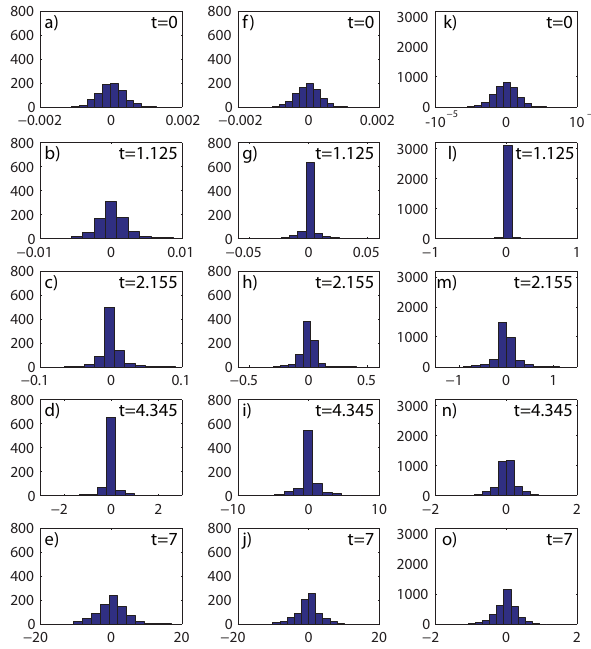
Fig. 4. Histograms of 20perturbations of an initial condition for (a) – (e) the simplified L96 model, (f) – (j) the slow variables x i of the L96 model with strong coupling ( h =1), and (k) – (o) the fast variable y j,i of the L96 model. For each column, the different rows from top to bottom represent the initial, three intermediate and the final times, corresponding to the horizontal lines depicted in Fig.